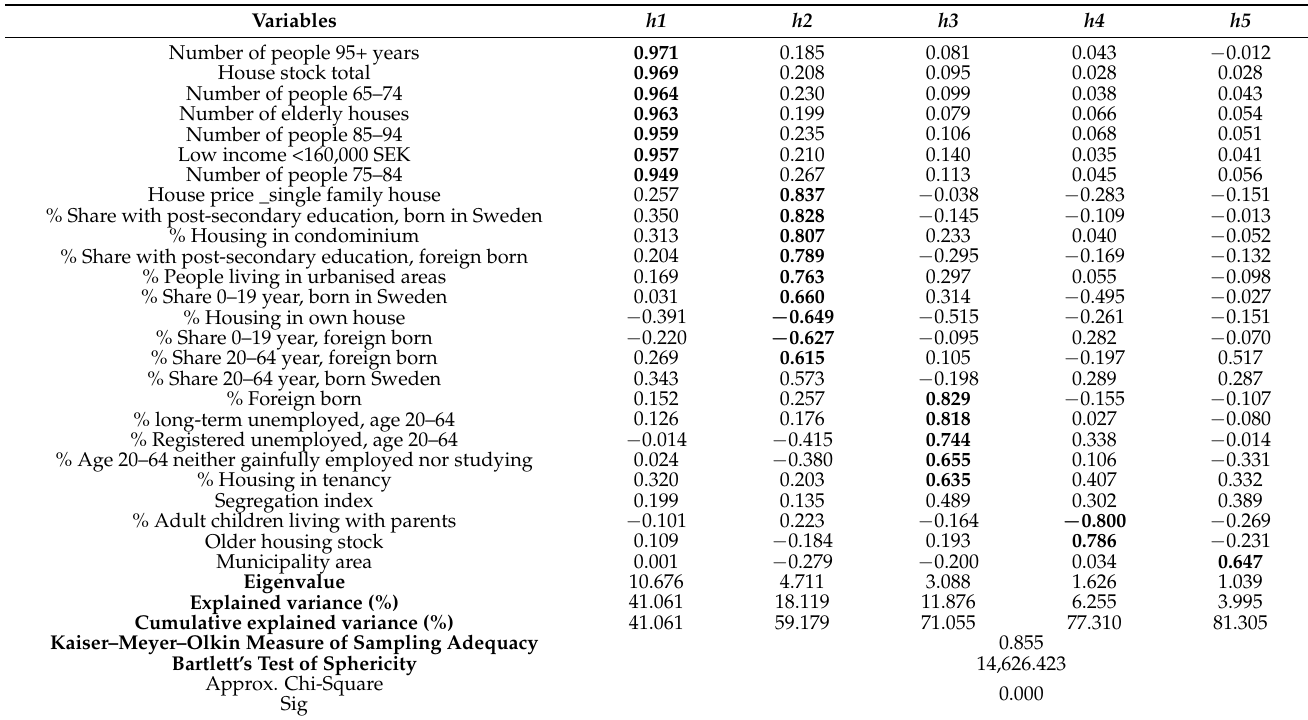
Table A2. Principal Component Analysis (PCA) for housing and interaction